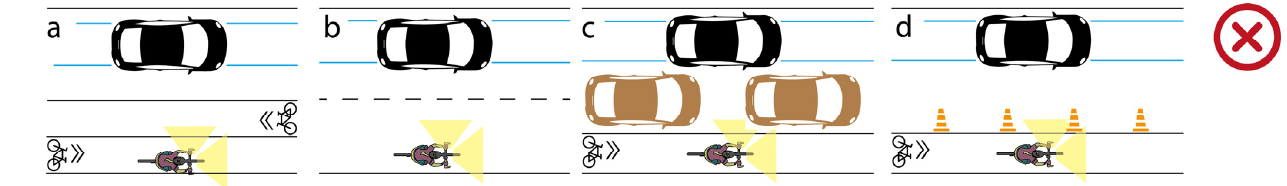
Figure 3. Cases considered to be overtakings. ( a ) and ( b ) overtaking by switching lanes; ( c ) overtak- ing in the absence of a dividing line; ( d ) overtaking along a bike lane; ( e – h ) overtaking in the pres- ence of parked vehicles.